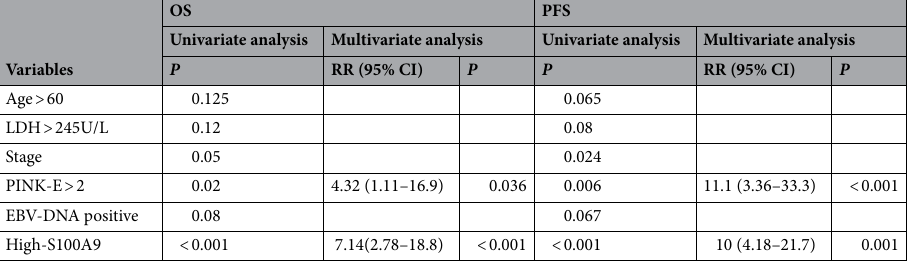
Table 2. Univariate and multivariate analysis of OS and PFS in NKTCL patients. LDH lactate dehydrogenase, EBV Epstein-barr virus, PINK-E prognostic index of natural killer lymphoma-Epstein-barr virus.